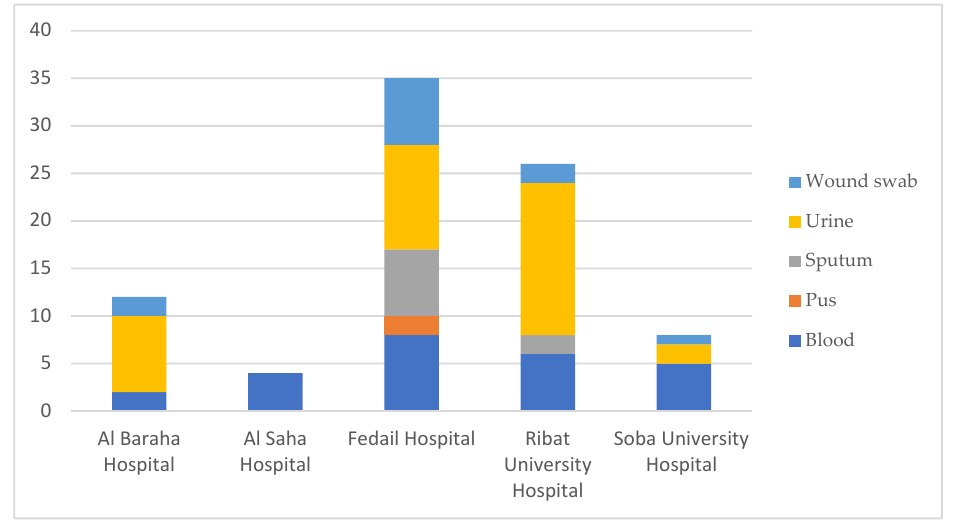
Figure 1. Details of isolate sources and hospitals. Table 1. Isolate details: date and type of sample, and